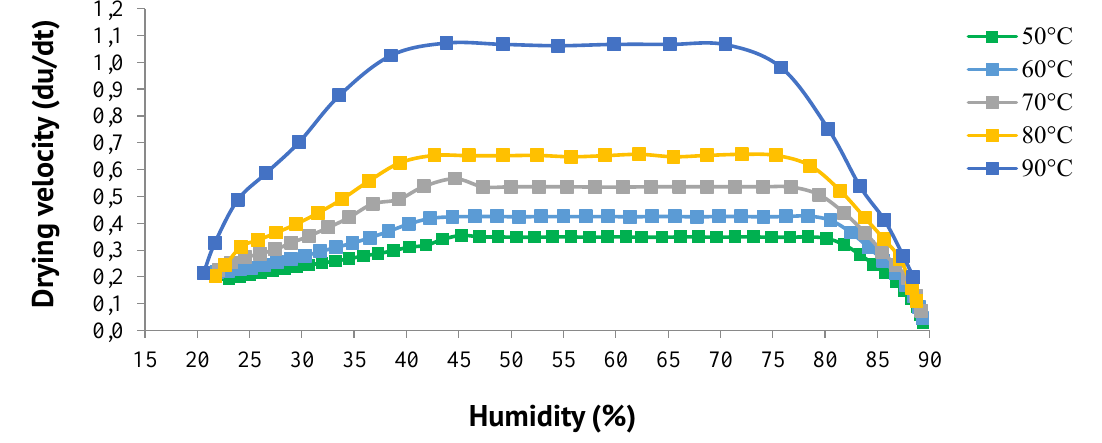
Figure 4. SPRINGCREST peaches different thermal agent temperatures drying velocity curves (Thermal agent velocity 2.0 m . s - 1 , thermal agent relative humidity 60.0%, slices thickness 3 . 10 -3